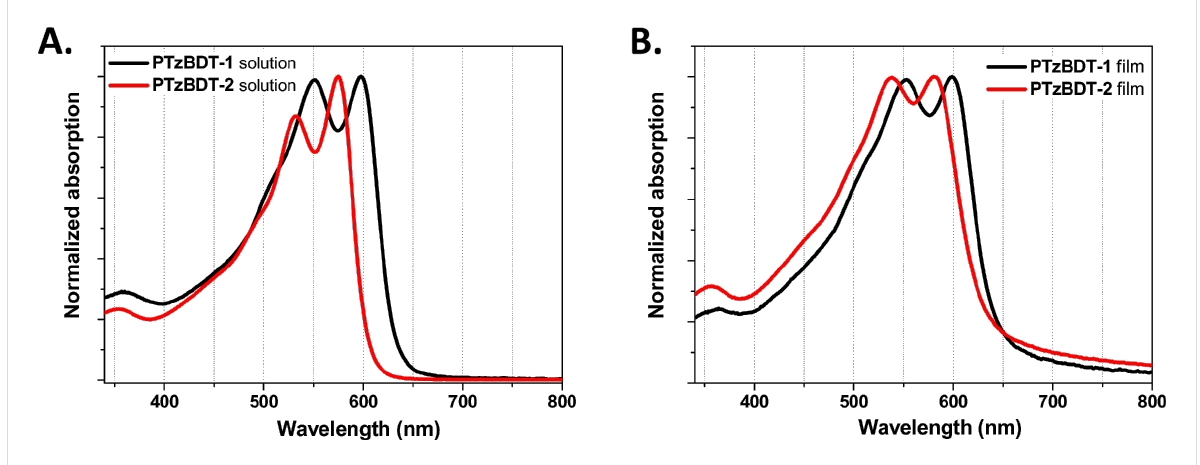
Figure 1: UV–visible absorption spectra of the pristine PTzBDT-1 and PTzBDT-2 (A) in chlorobenzene and chloroform, respectively and thin film processed from chlorobenzene (PTzBDT-1) and chloroform (PTzBDT-2) (B).